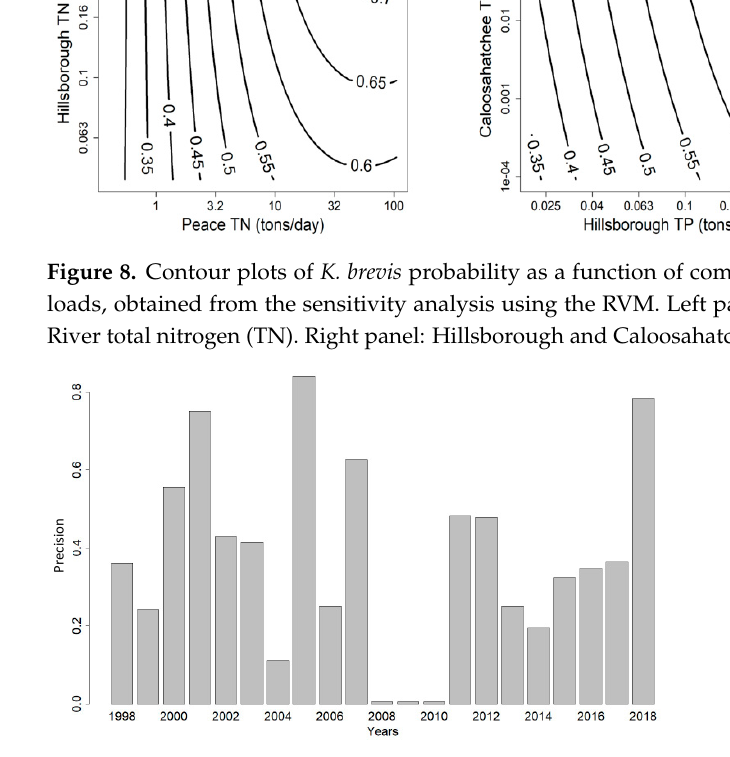
Figure 9. Precision of the RVM model by year.